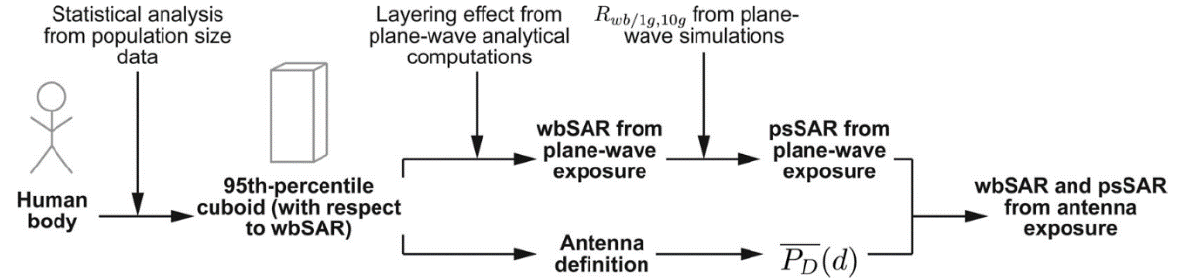
Figure 8. Diagram representing the steps in elaborating the SAR estimation formulas.